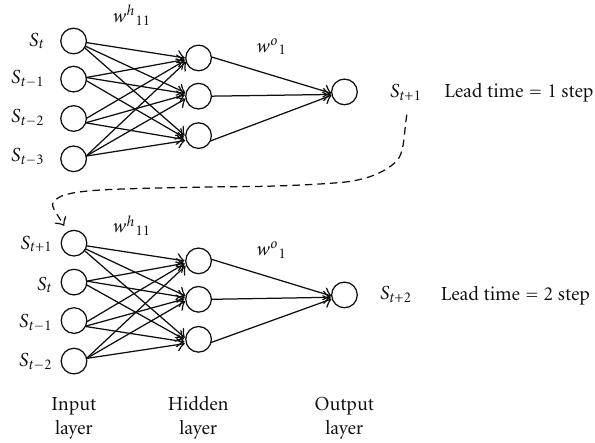
Figure 1: Typical Feed-forward Neural